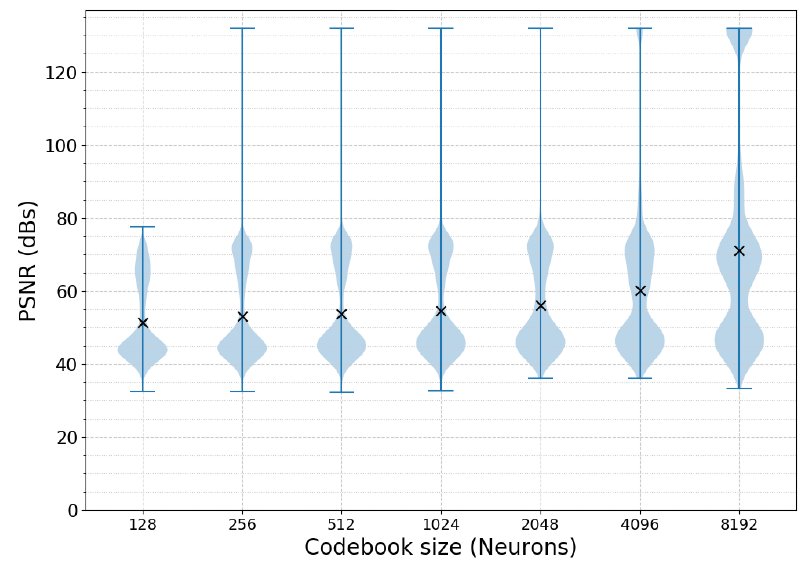
Figure 9. Peak signal-to-noise ratio (PSNR) distribution vs. codebook centroids. (Sampling Freq. = 100 Hz, Window size = 1 s).